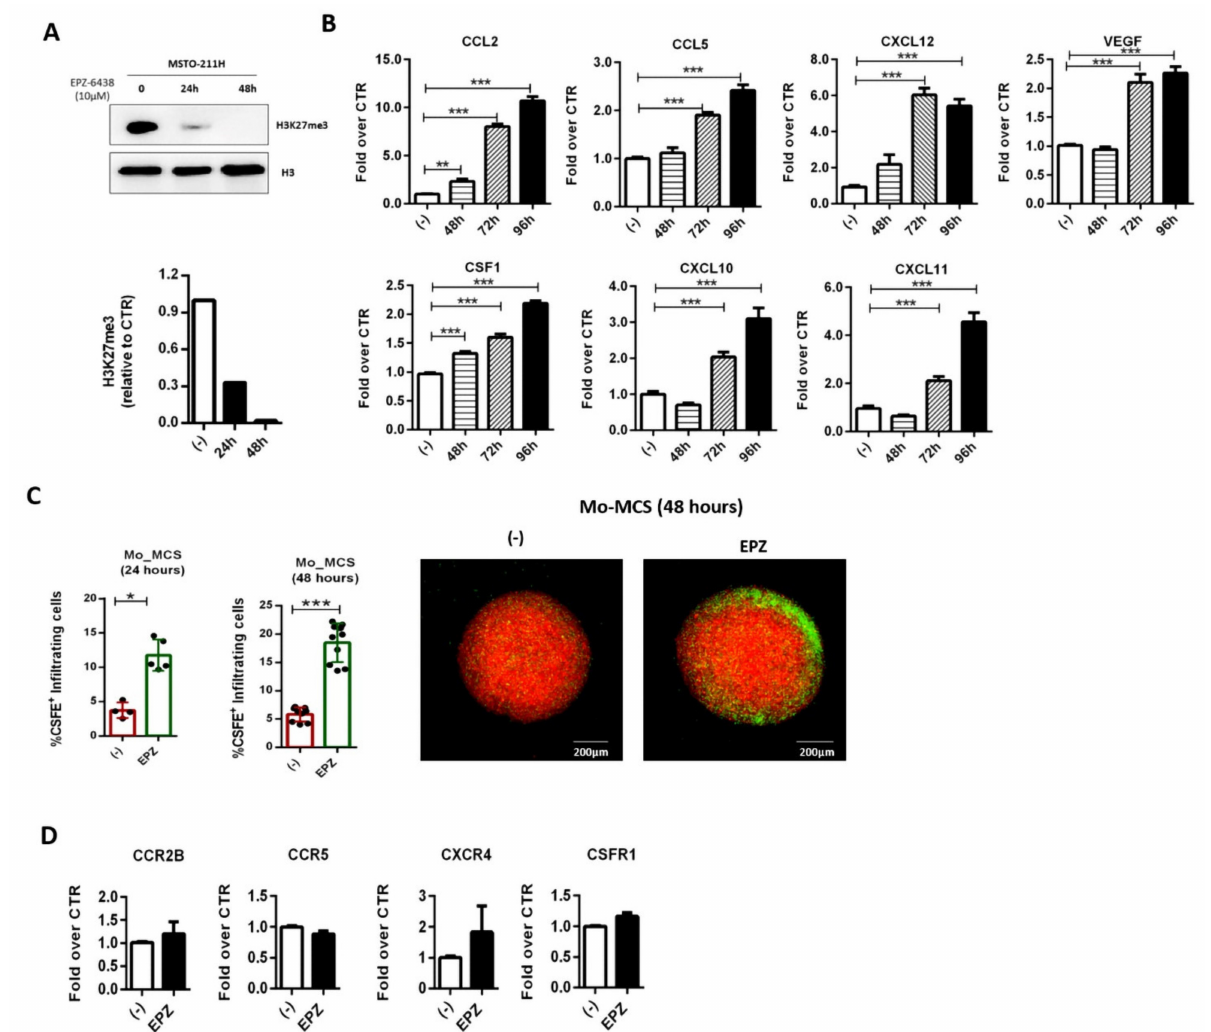
Figure 3. EZH2 inhibition enhances monocyte recruitment in MCS. ( A ) MSTO-211H cells were treated with EPZ-6438 (10 µ M) or DMSO (-) for 24 and 48 h, then core histone proteins were extracted and analyzed by Western blot for H3K27me3 levels. Histone H3 was used as loading control; ( B ) RT-PCR analysis of total RNA extracted from MCS treated or not (-) with EPZ-6438 (10 µ M) for 48, 72, and 96 h. Selected monocyte chemoattractants (CCL2, CCL5, CXCL12, CSF1, VEGF) were evaluated. β -Actin was used as housekeeping gene. Normalized qPCR results are shown as fold increase over control. Data are shown as mean ± SEM of three different experiments. *** p < 0.001 by two-tailed t -test, N = 3; ( C ) according to their time of life (about 96 h) MCSs were treated with EPZ-6438 (10 µ M) for 72 or 48 h and subsequently cocultured with CSFE-labeled monocytes for 24 or 48 h, respectively. Infiltrating monocytes were quantified using Fiji-ImageJ (NIH)-win64 software. Representative images are shown. Scale bars: 200 µ m. Data are shown as mean ± SD * p < 0.05 and *** p < 0.001 by two-tailed unpaired t -test; 24 h (-) N = 4, EPZ N = 5; 48 h (-) N = 7, EPZ N = 12; ( D ) monocytes were treated with EPZ-6438 (10 µ M) for 48 h and analyzed for the expression of chemokine/growth factor-receptors (CCR2B, CCR5, CXCR4, and CSFR1) by qPCR. β -Actin was used as housekeeping gene. Normalized qPCR results are shown as fold increase over monocytes treated with DMSO only